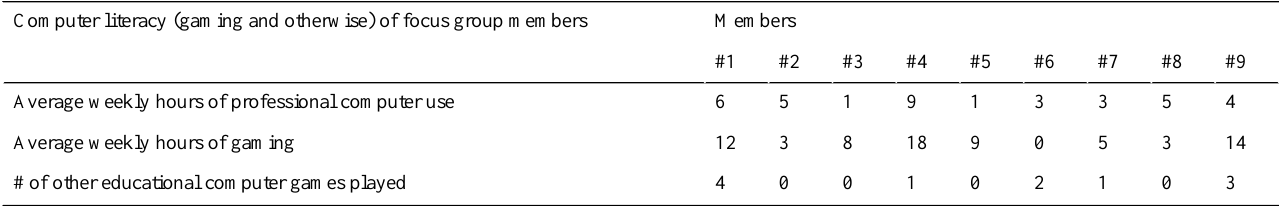
Table 1. Breakdown of the group members’computer, gaming, and educational gaming familiarity. MembersComputer literacy (gaming and otherwise) of focus group members